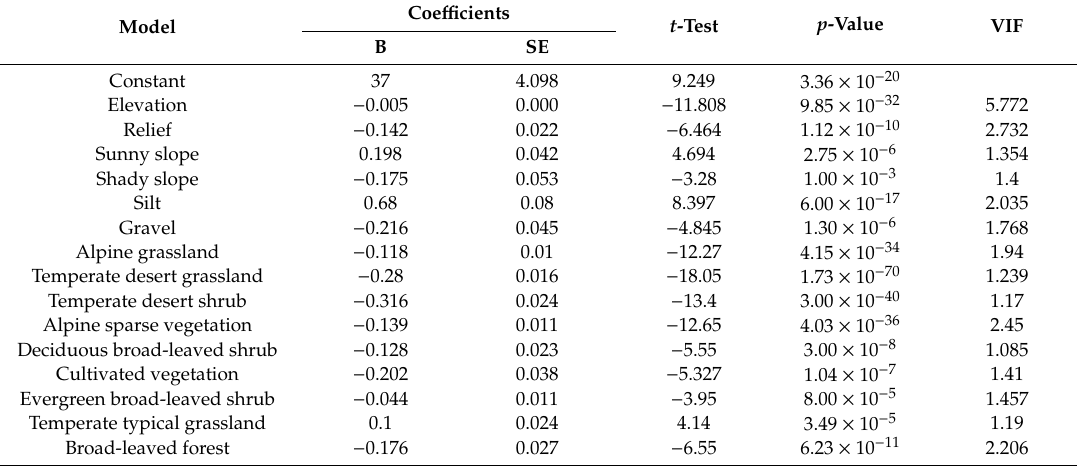
Figure 11. Relationships between the drought event characteristics and vegetation characteristics between 1982 and 2015. Table 3. Estimated parameter and significance levels in the multivariate linear regression analysis. Variance inflation factor